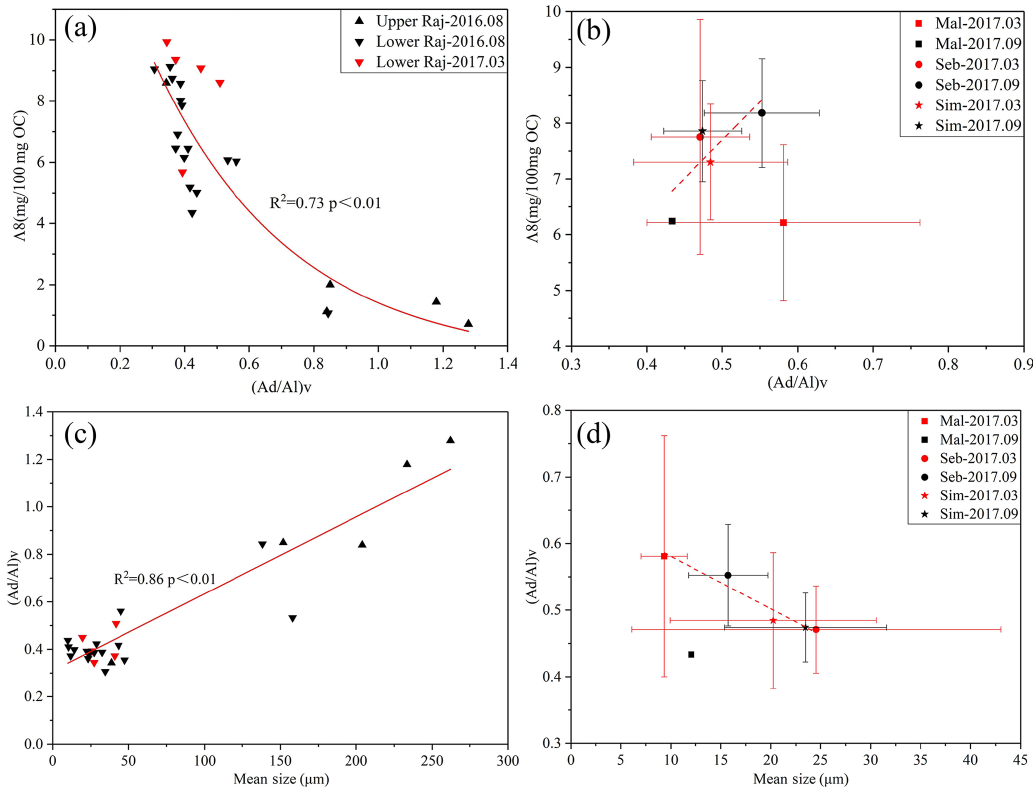
Figure 4. Variation in ( Ad / Al ) V with (cid:51) 8 values of sediments from (a) the Rajang and (b) the small river systems. Variation in ( Ad / Al ) V with mean sediment grain size for (c) the Rajang and (d) the small river systems.